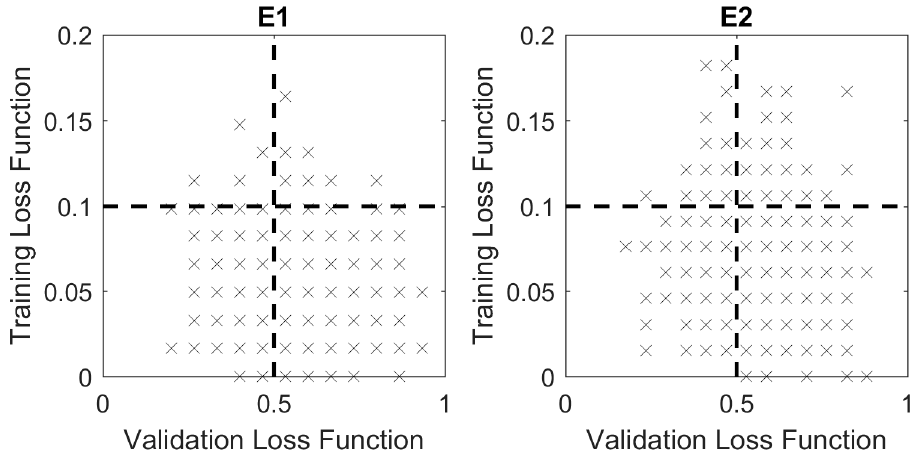
Figure 6. Validation and training loss function relation for the one thousand NN of experiment 1 (E1: restrictive dataset) and experiment 2 (E2: obstructive dataset).